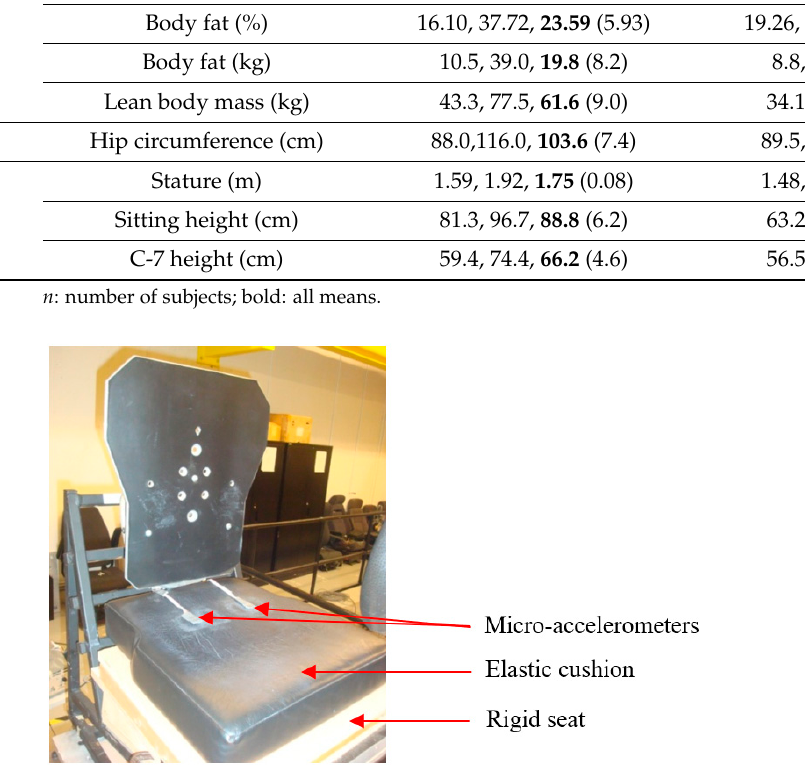
Figure 1. Elastic cushion used in the experiment and mounting of accelerometers on the cushion.